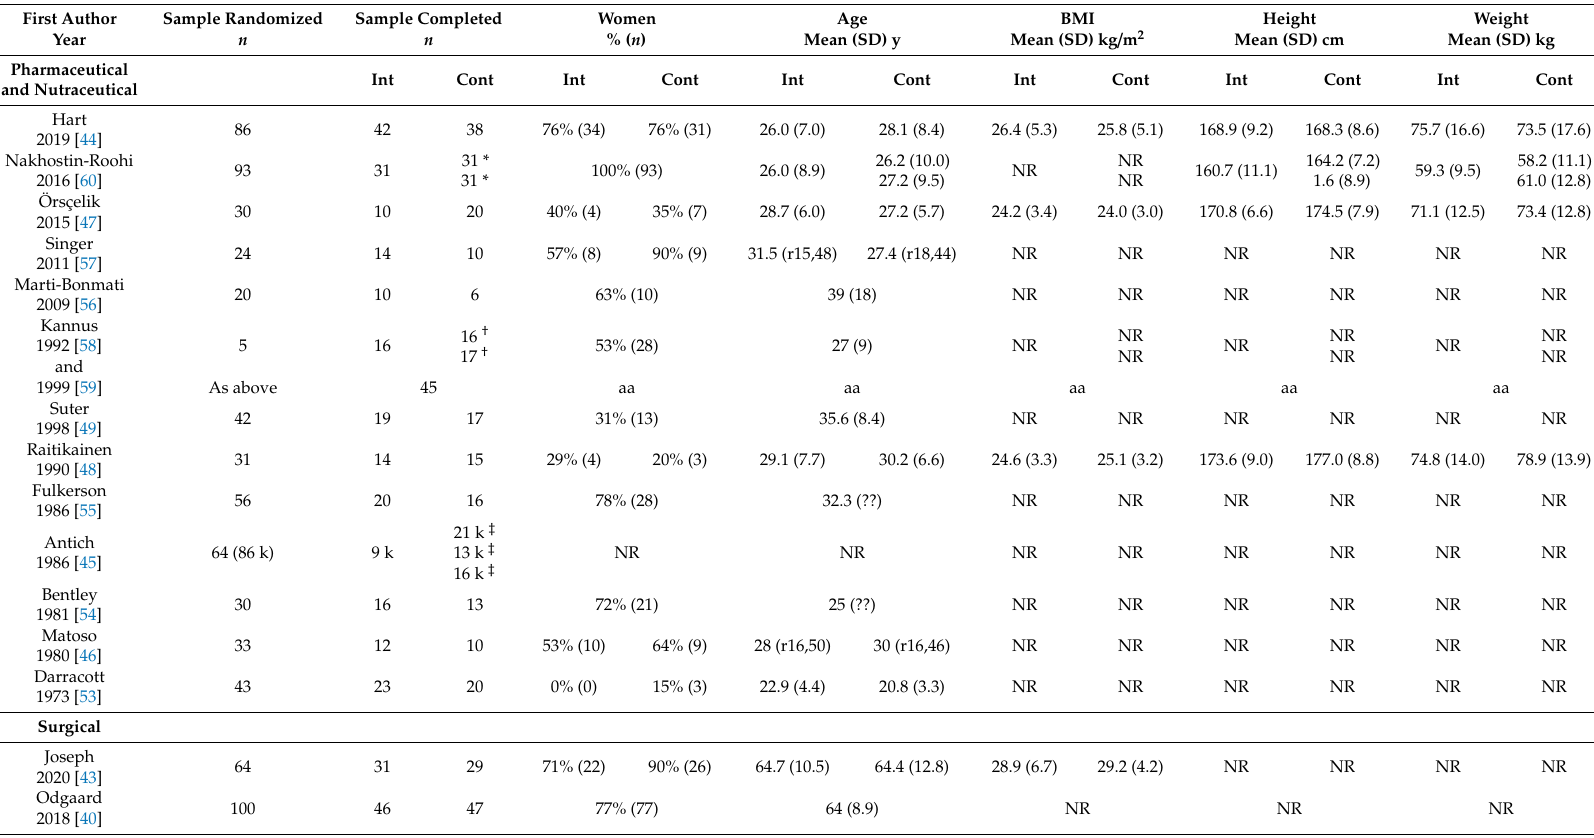
Table 2. Participant